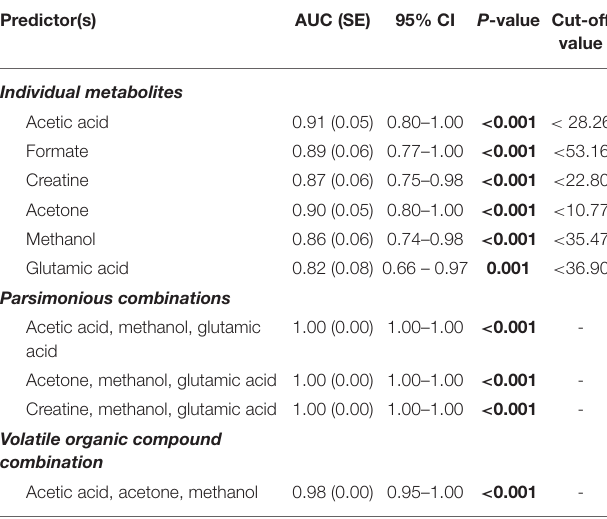
TABLE 4 | ROC curve summary predicting MBRS status.